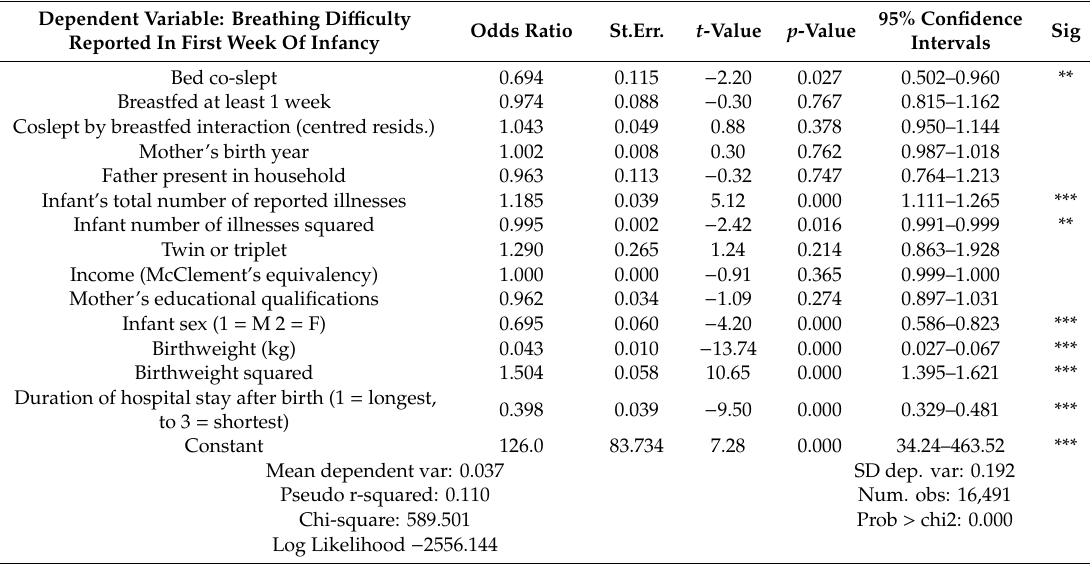
Table 3. Logistic regression results.